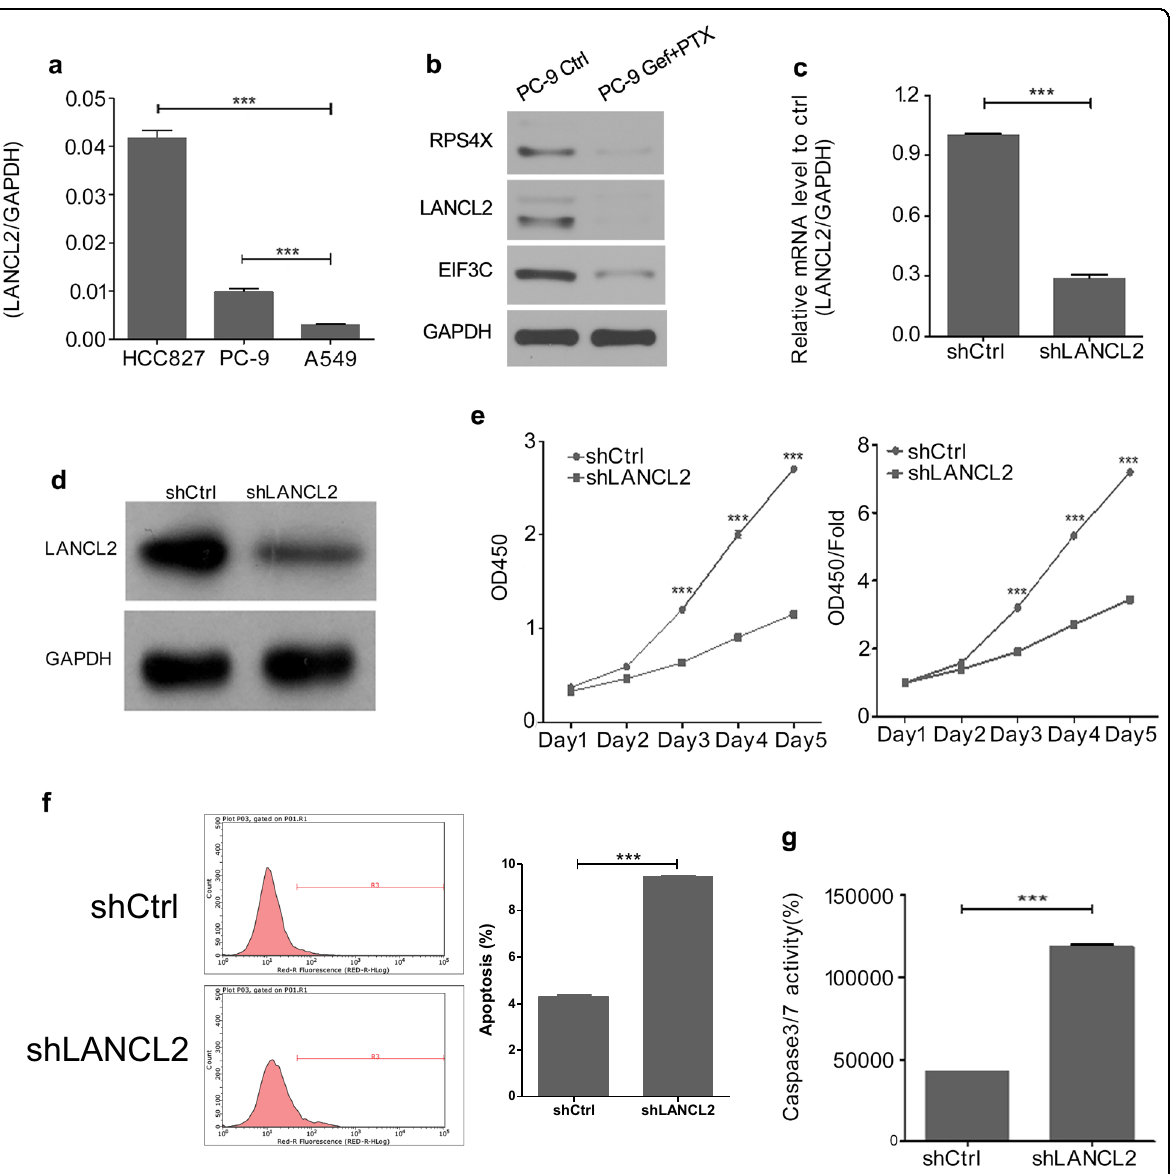
Fig. 2 LANCL2 knockdown inhibits PC9 cell proliferation. a LANCL2 mRNA expression levels in PC9, HCC827, and A549 cells. b Immunoblotting analysis of RPS4X, LANCL2, and EIF3C protein expression in PC9 cells following vehicle control (Ctrl) or 10 nM ge fi tinib + 20 nM pemetrexed (Gef + PTX) combination therapy. c mRNA and d protein expression levels of LANCL2 in shLANCL2- or shCtrl-infected PC9 cells. e CCK-8 cell proliferation assay (raw OD450 data (left) and relative fold-change in OD450 (right)) and f fl ow cytometry analysis of apoptosis using Annexin V staining in shLANCL2- and shCtrl-infected PC9 cells. g Caspase-3/7 activity in shLANCL2- and shCtrl-infected PC9 cells. * p < 0.05; ** p < 0.01; and *** p < 0.001 vs. shCtrl. Data presented as means ± SDs. All in vitro experiments: three biological replicates × three technical